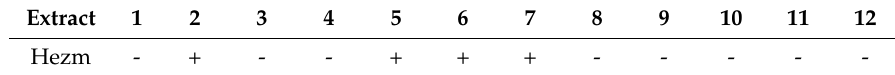
Table 1. Phytochemical prospection of the hexanic Zea mays L. extract.